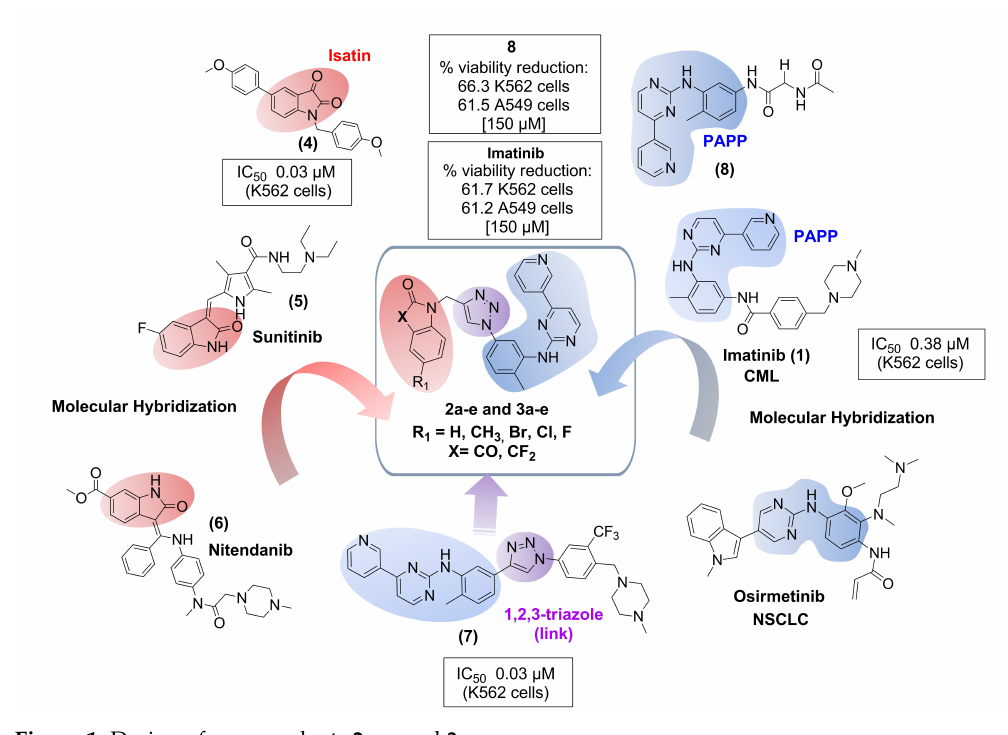
Figure 1. Design of new products 2a–e and 3a–e .